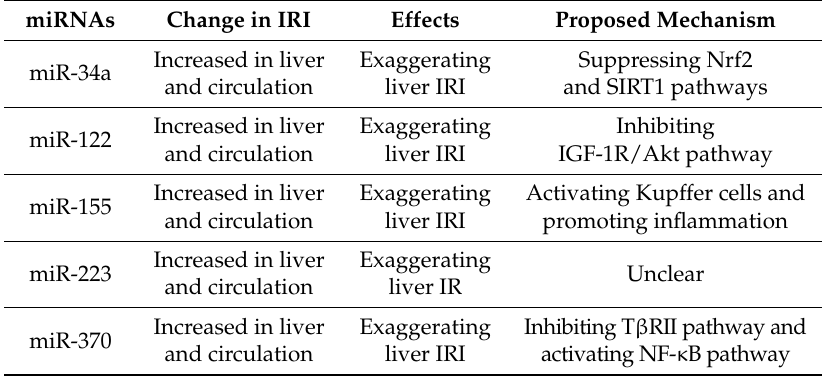
Exaggerating Suppressing Nrf2 liver IRI and SIRT1 pathways Exaggerating Inhibiting liver IRI IGF-1R/Akt pathway Exaggerating Activating Kupffer cells and liver IRI promoting inflammation Exaggerating Unclear liver IR Exaggerating Inhibiting T β RII pathway